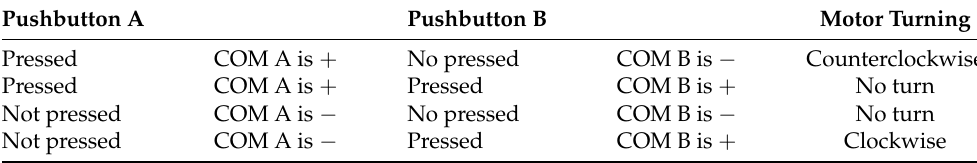
Table 1. Possible circuit configurations. NO is Connected to + , NC is Connected to −